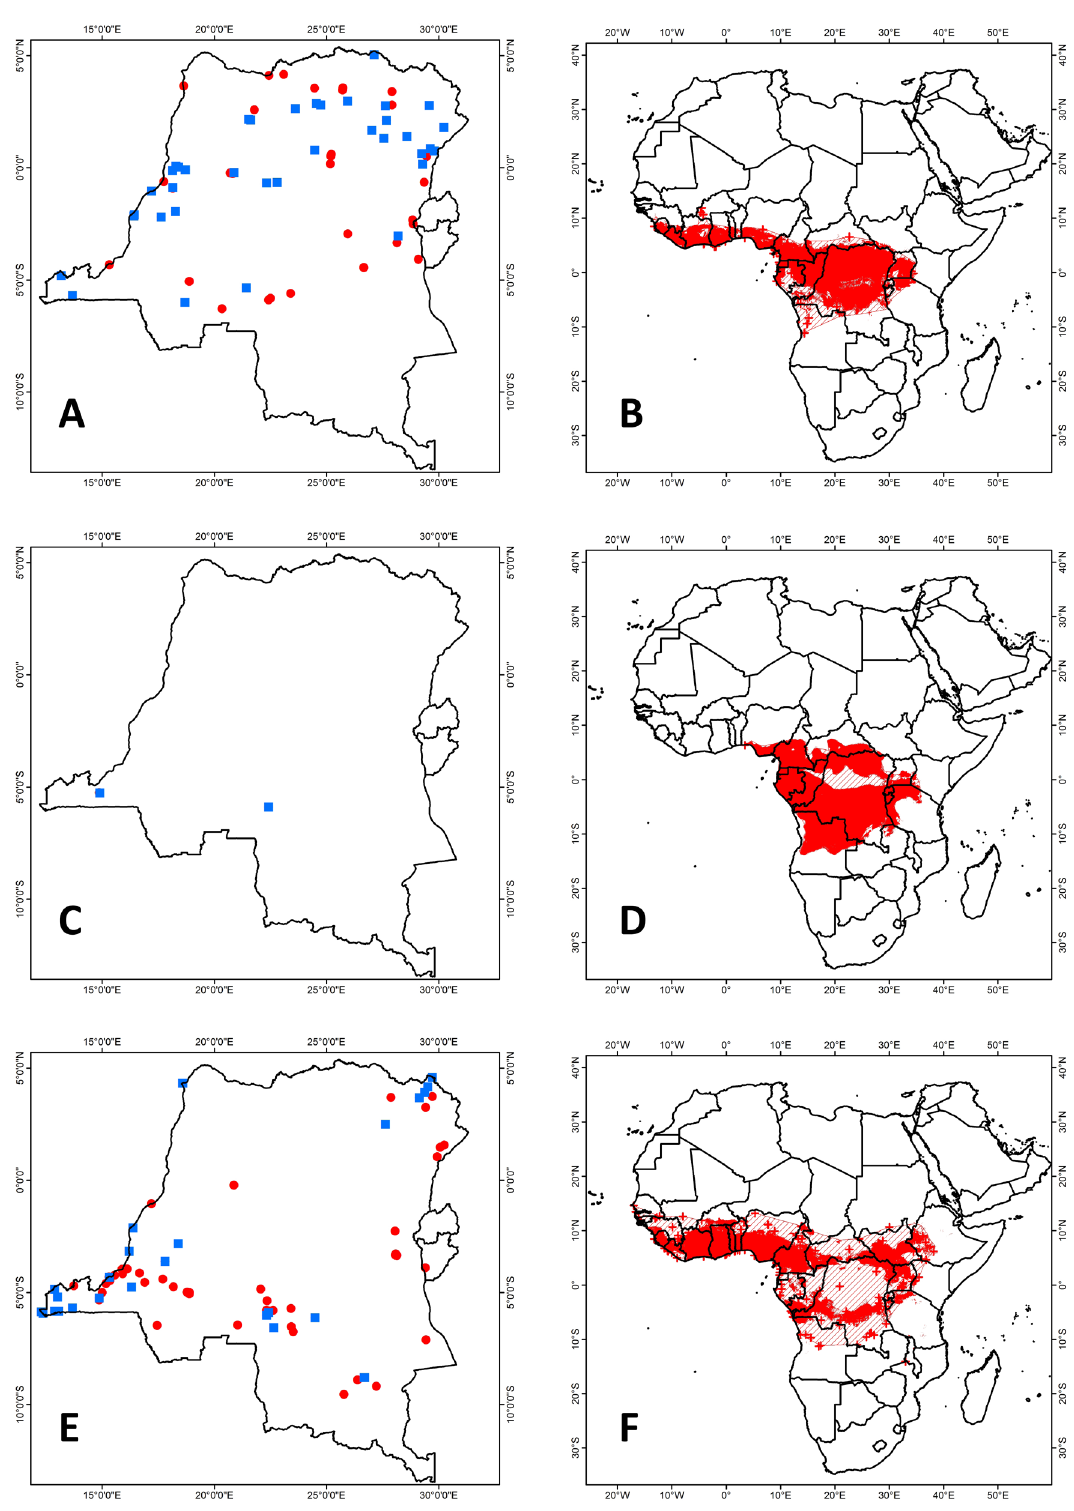
Fig. 6. Distribution maps. A–B . Hypsignathus monstrosus H. Allen, 1862. C–D .